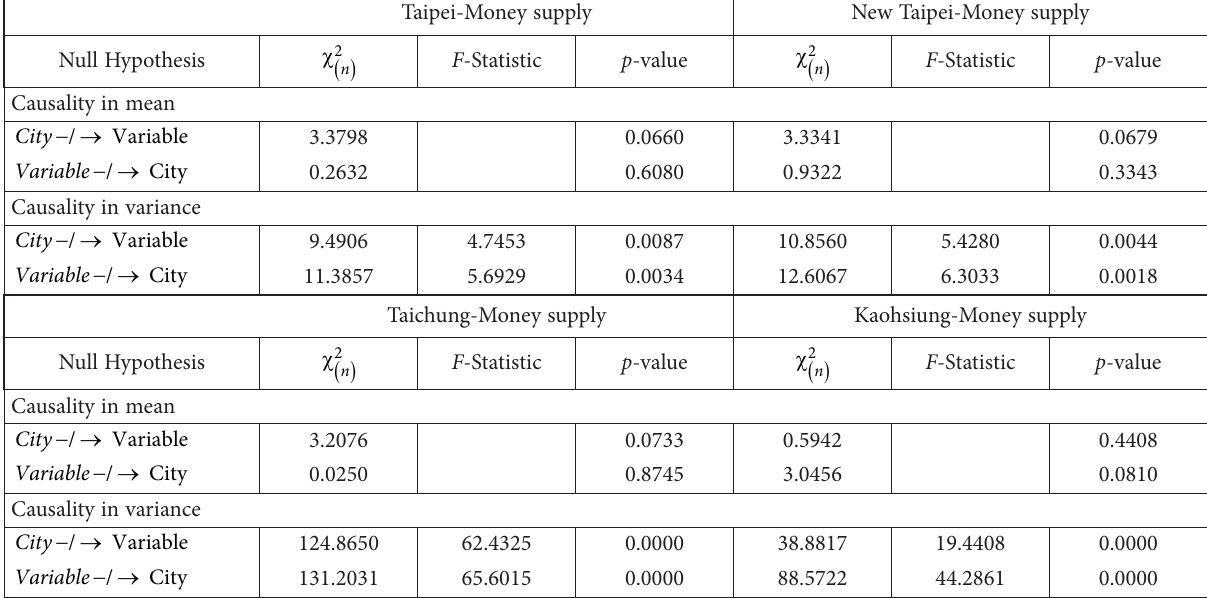
Table 10. Relationship between the money supply and the housing